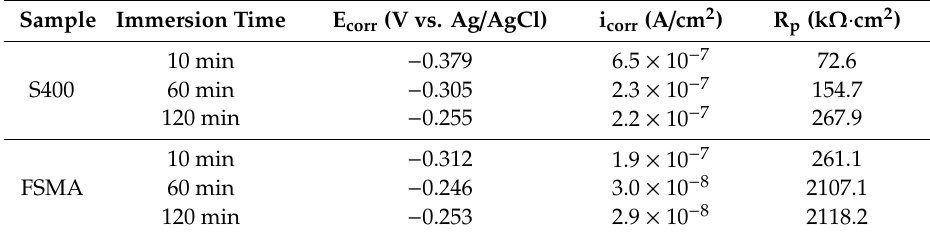
Table 4. Estimated free corrosion potential (E corr ), free corrosion current density (i corr ), and polarization resistance (R p ) from the potentiodynamic polarization curves in Figure